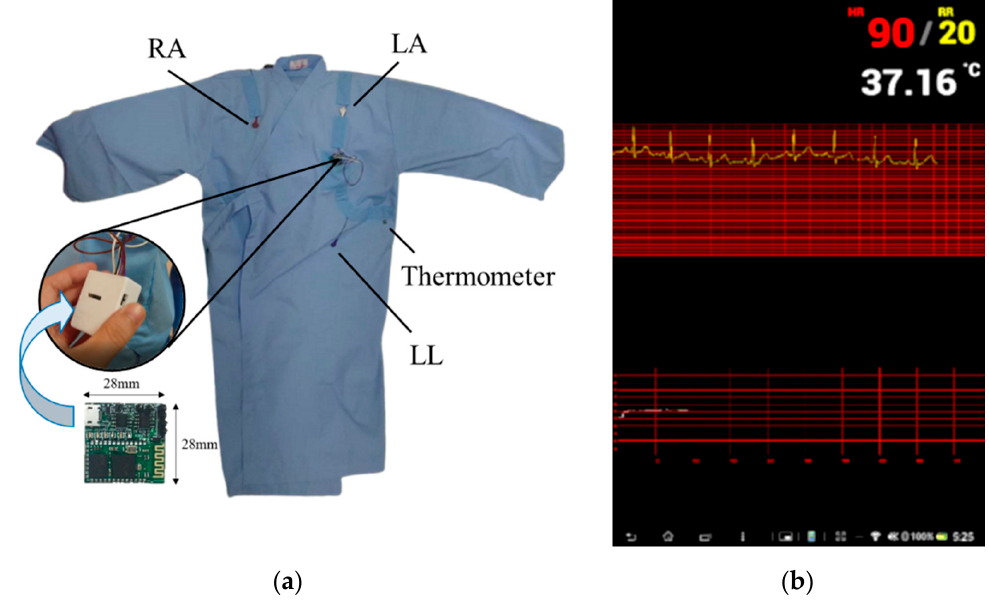
Figure 2. ( a ) Electrode positions on the vital signs sensing gown and placement of the miniaturized circuit. ( b ) Vital signs display on a portable device.